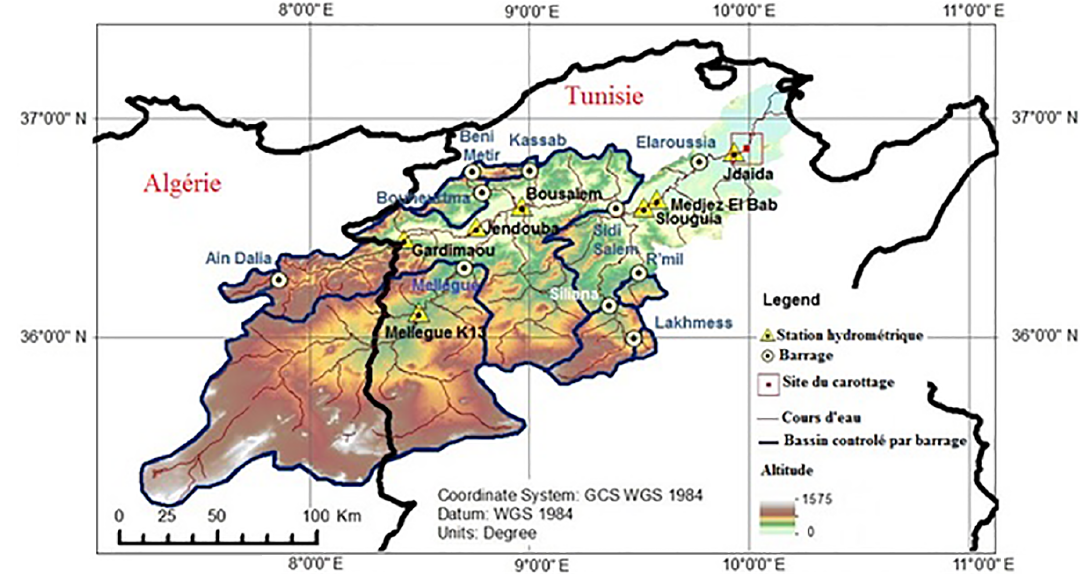
Figure 1. Localisation des grandes stations hydrométriques et des barrages sur le bassin versant de la Medjerda, et site du